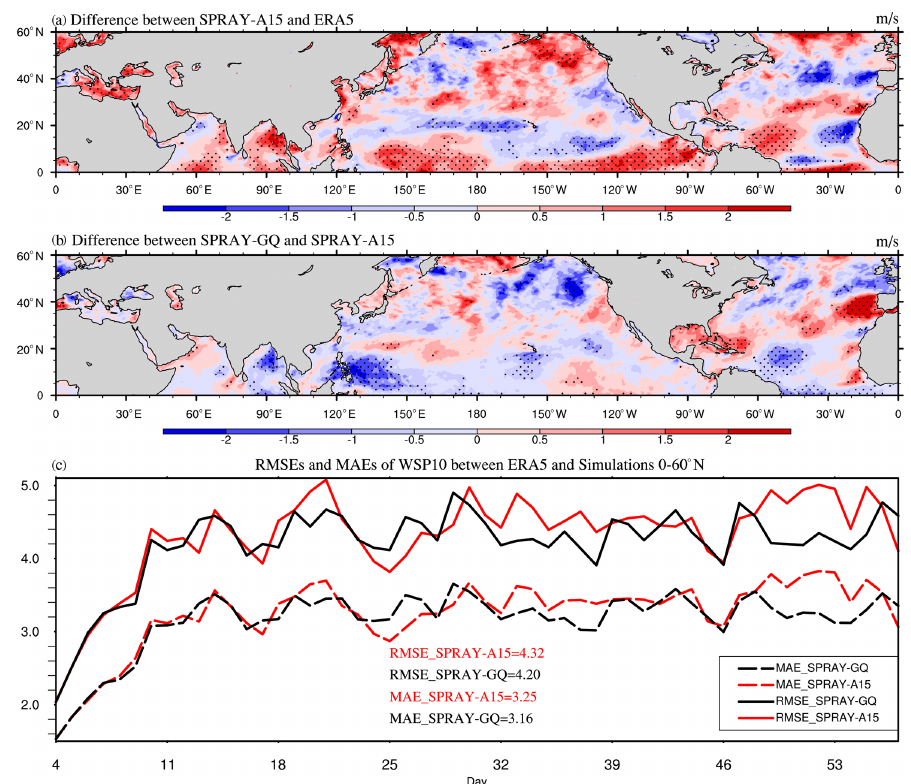
Figure 10. The 53d average WSP10 (ms − 1 ) differences between SPRAY-A15 and ERA5 ( a ; SPRAY-A15 minus ERA5), the differences between SPRAY-GQ and SPRAY-A15 ( b ; SPRAY-GQ minus SPRAY-A15), and the time series of domain-averaged RMSE and MAE ( c ; 0–360 ◦ E, 0–60 ◦ N) in January–February 2017. The first 3d simulation is discarded. The dotted areas are statistically significant at 95% confidence